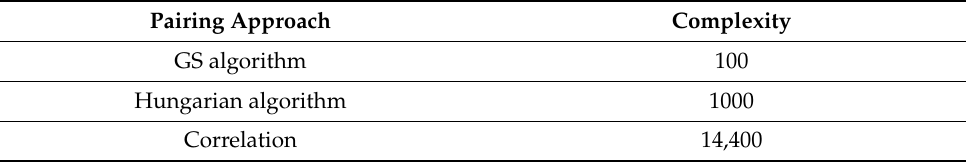
Table 5. Complexity calculations for different pairing approaches.